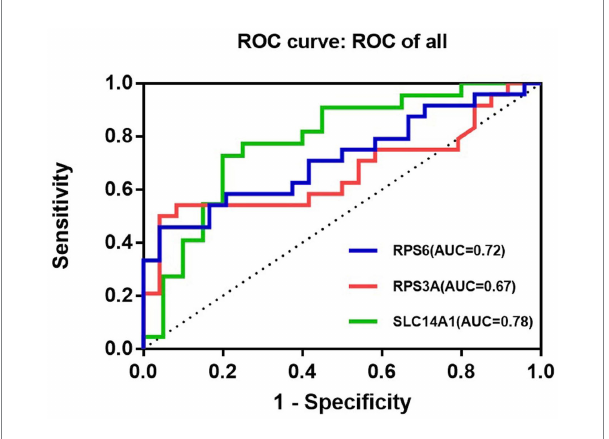
FIGURE 5 Receiver Operating Characteristic (ROC) curves of SLC14A1 / RPS6 / RPS3A